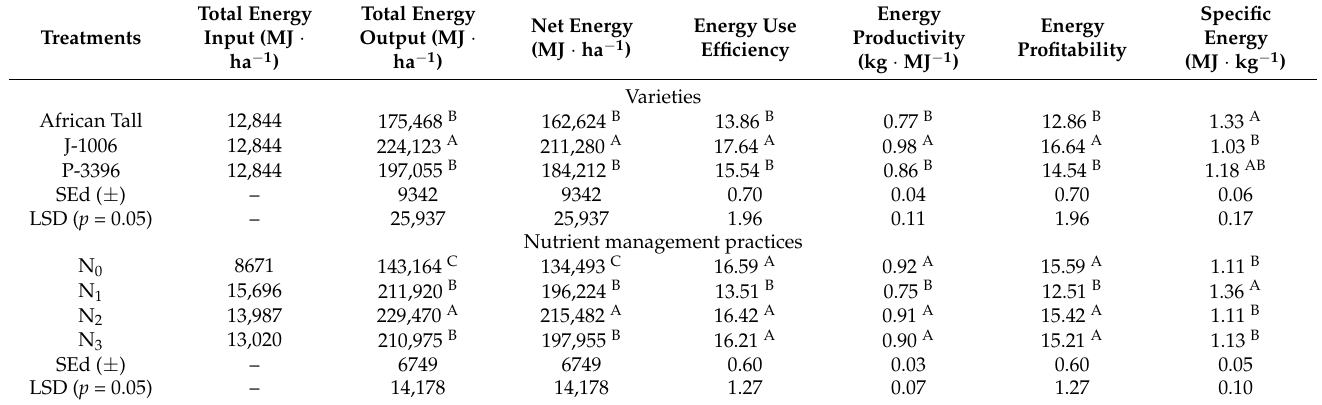
Table 4. Total energy input, output, and energy indices of fodder maize varieties sown under different nutrient management practices (mean of two